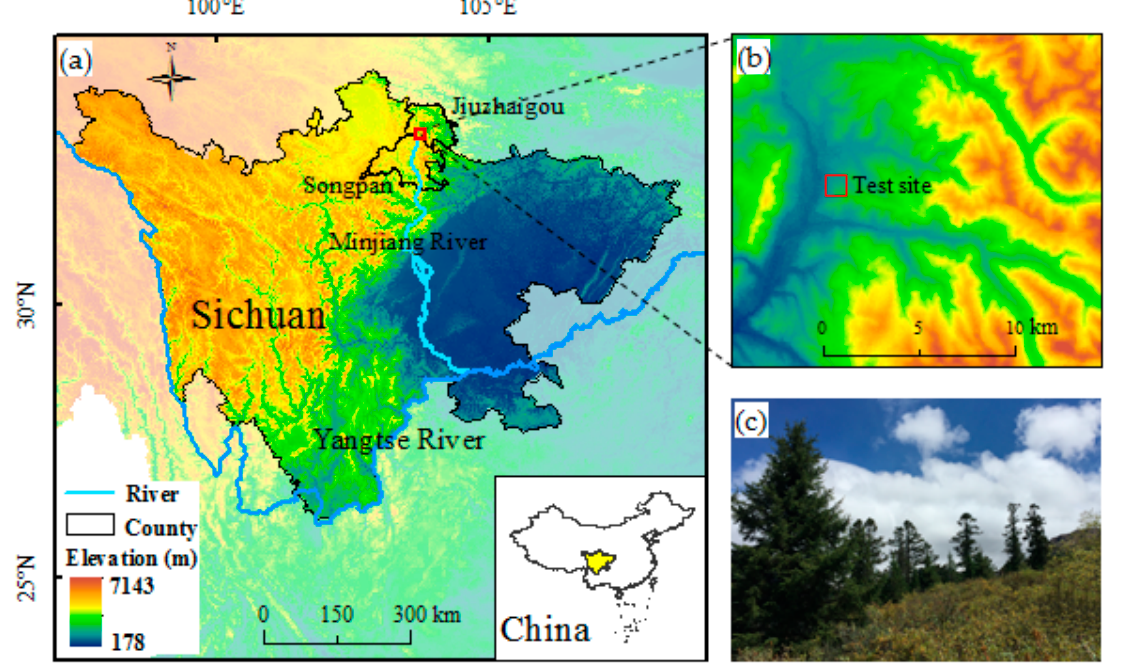
Figure 1. Location of the test site and the dark subalpine coniferous forest.